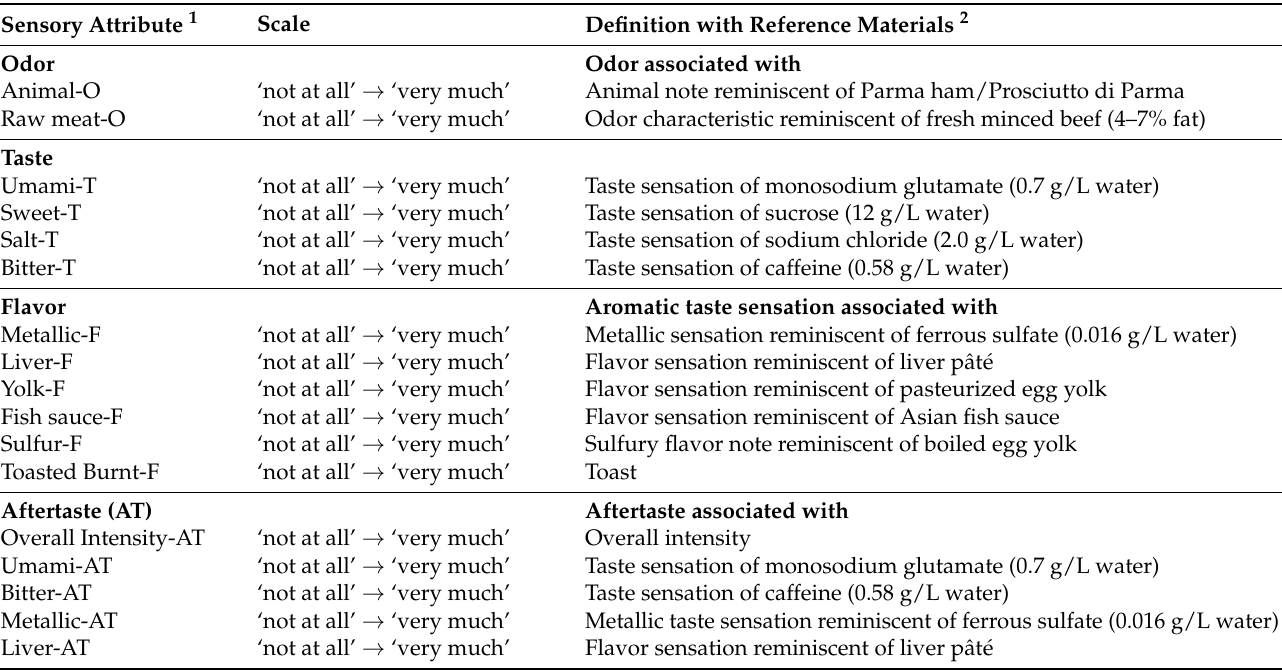
Table 1. List of sensory attributes with definitions developed for the